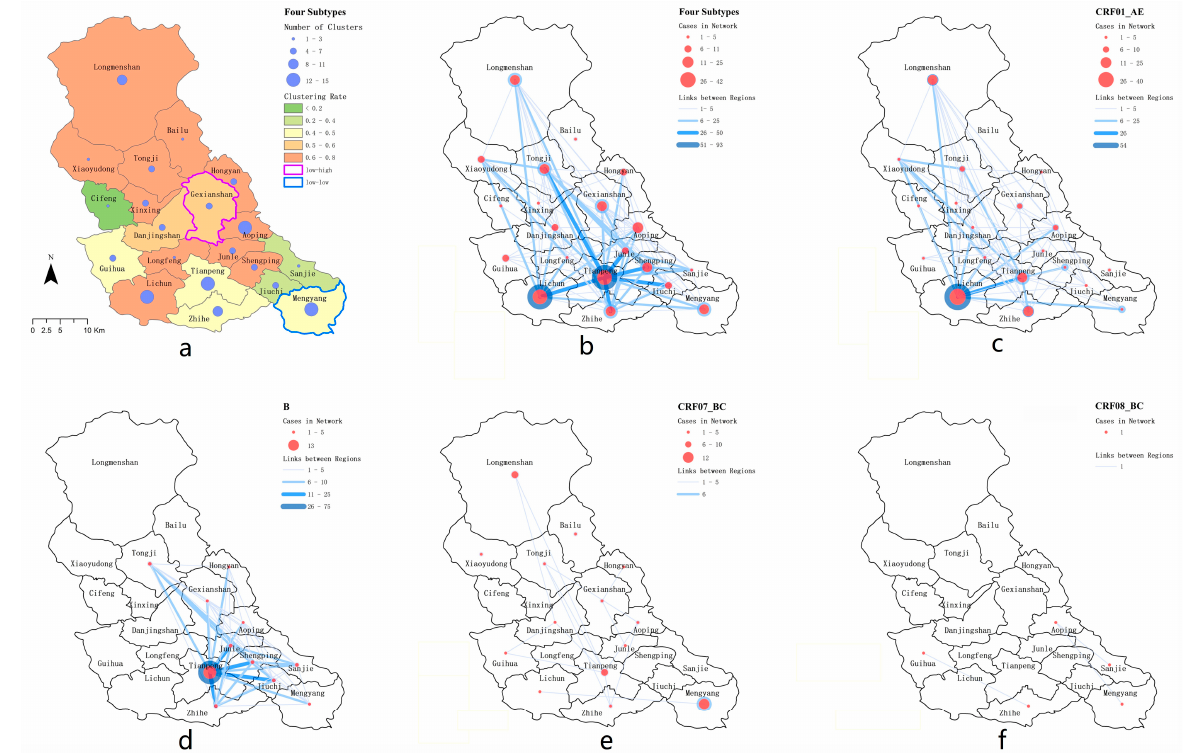
Figure 5. Spatial clustering and spatial transmission graph of the molecular propagation network. ( a ) Township area and cluster analysis, ( b ) spatial transmission of strain subtypes, ( c ) spatial transmission of strain subtype CRF01_AE, ( d ) spatial transmission of strain subtype B, ( e ) spatial transmission of strain subtype CRF07_BC, ( f ) spatial transmission of strain subtype CRF08_BC.